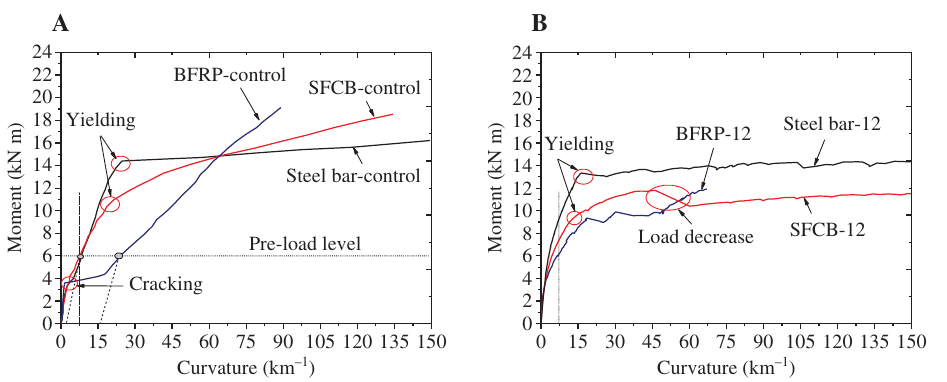
Figure 8: Moment-curvature diagrams at the pure bending section before and after 12 months of exposure. (A) Control specimens and (B) After 12 months of